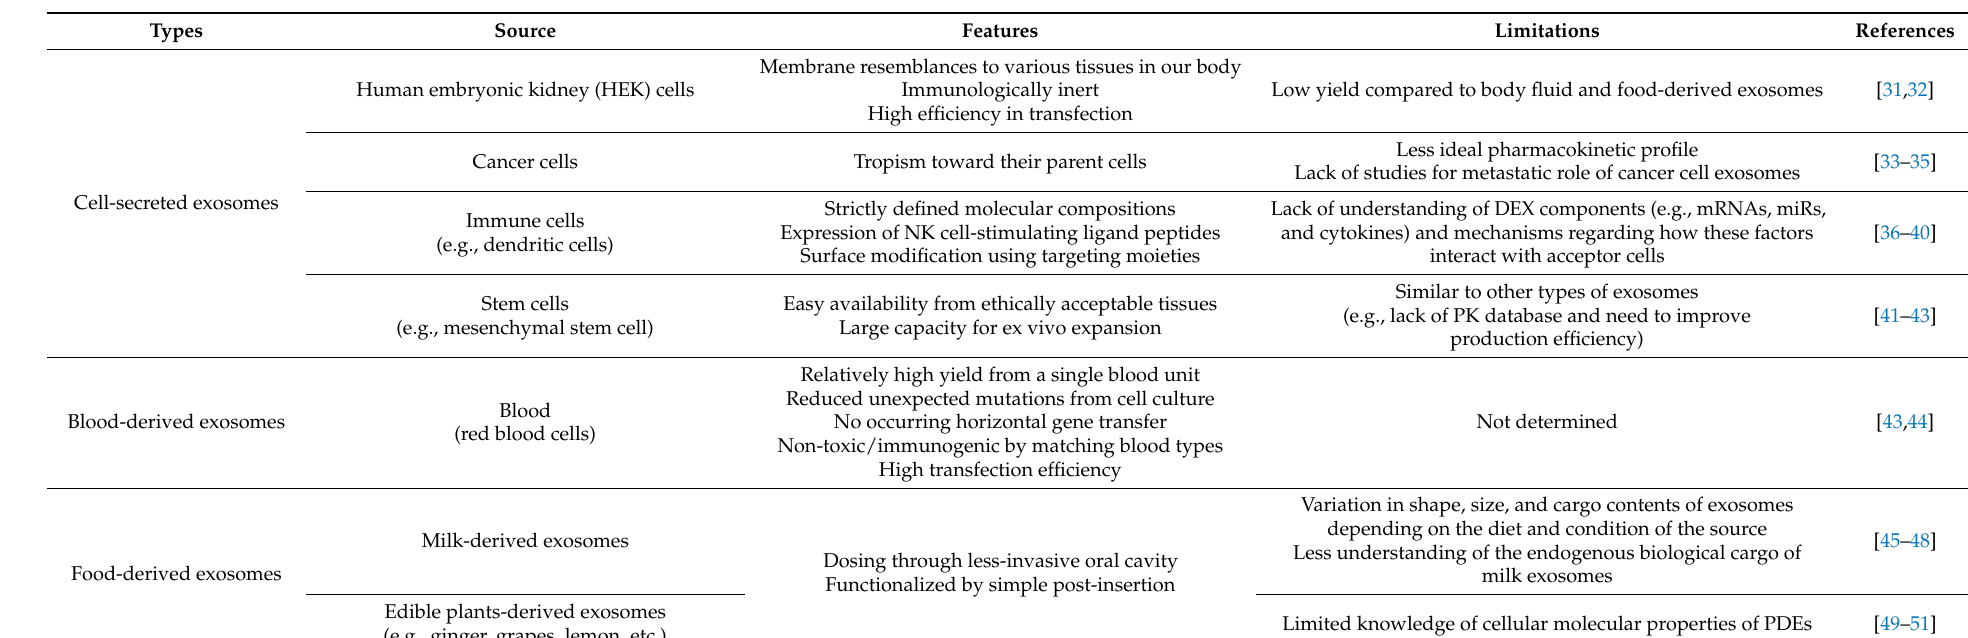
Table 1. Different types of exosomes originated from various sources and their